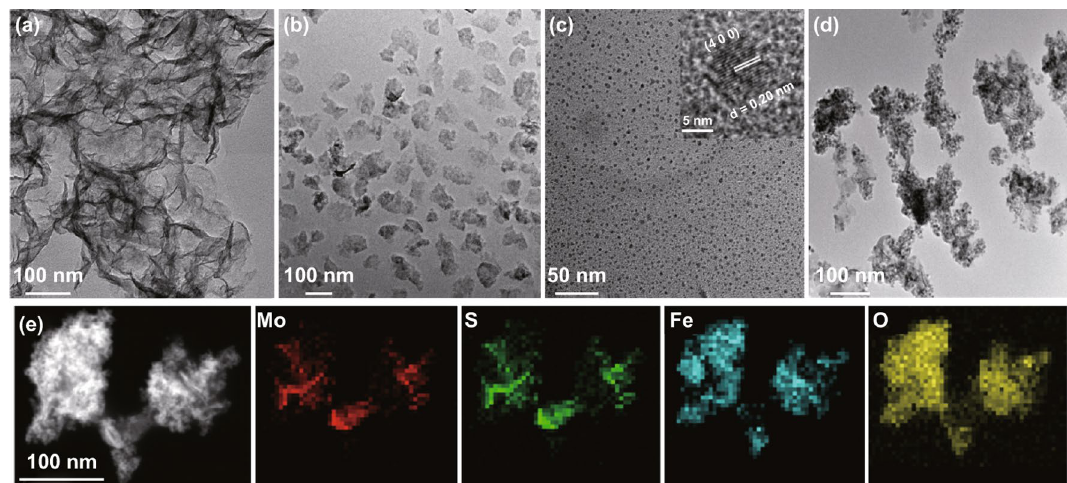
Fig. 1 Characterization of FeO/MoS 2 -BSA nanocomposites. a , b TEM images of large and small MoS 2 nanosheets. c , d TEM images of FeO nanoparticles and